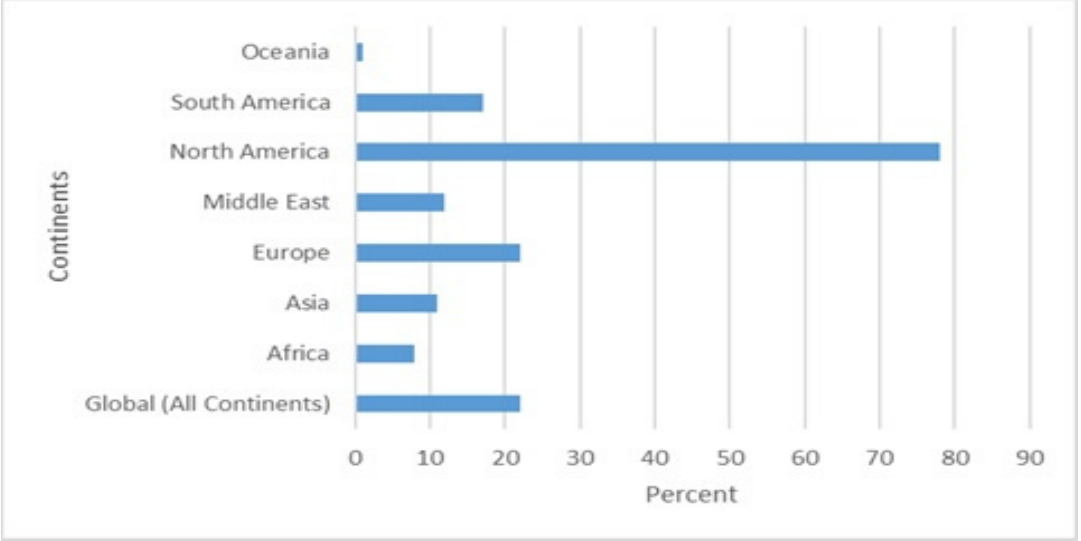
Figure 14. Demographics of geographic footprint.